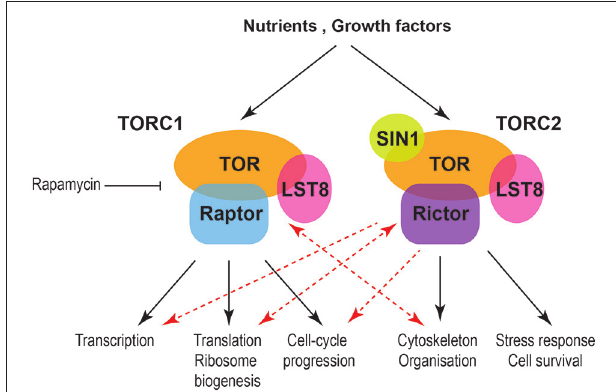
FIGURE 1 | Schematic indicating processes affecting cell size and growth downstream of mammalian TORC complexes. Black arrows indicate well-established relationships between TORC1 and TORC2 with temporal and spatial aspects of cell growth, respectively. Red arrows indicate new functional connections while double red arrows indicate a cross-regulation between TORC1 and cytoskeleton as well as TORC2 and